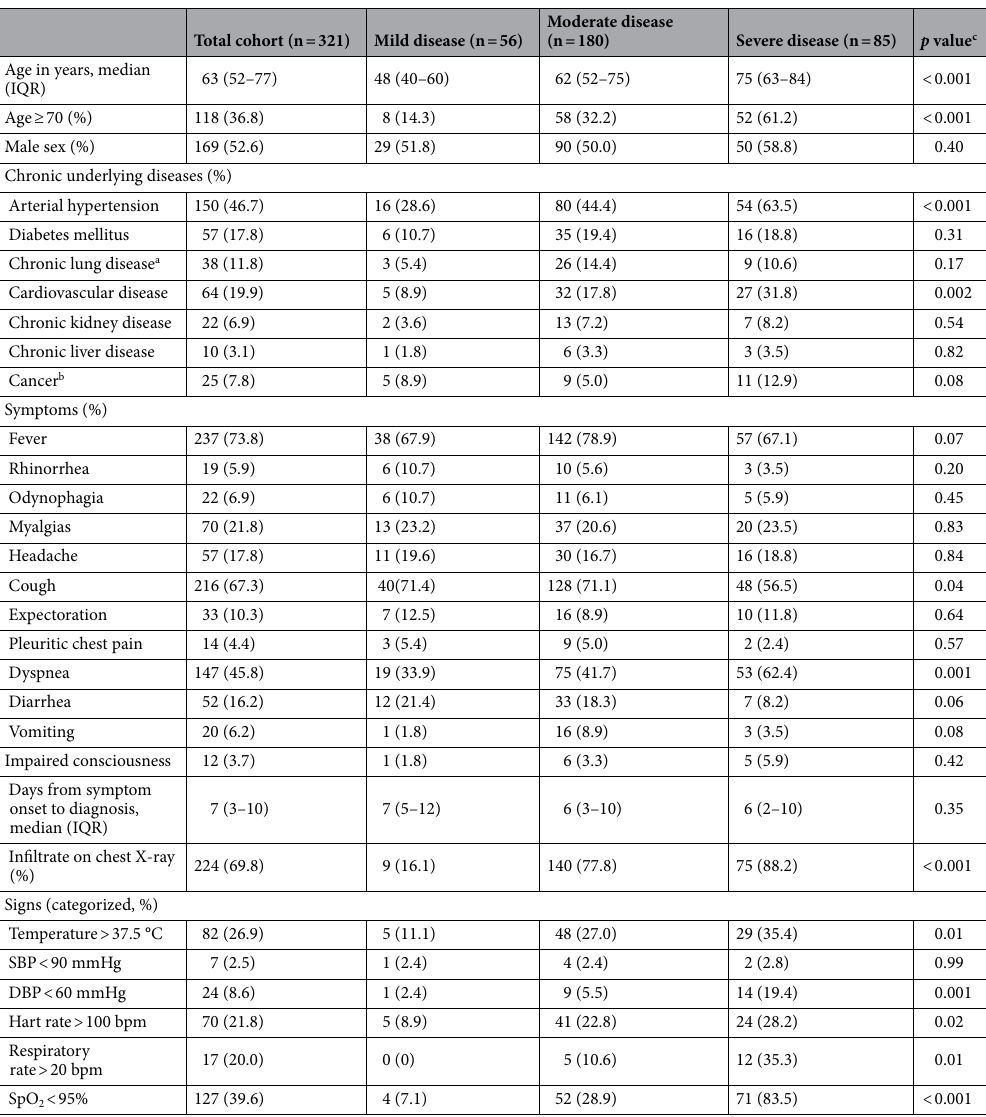
or hematologic malignant neoplasms. c Across all three